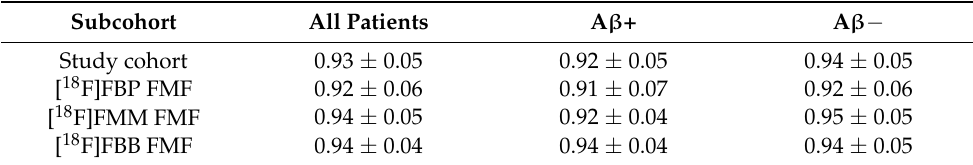
Figure 2. Intensity profiles and correlation charts with least squares line of the mean SUVRs of FMFs and [ 18 F]FDG PET. ( a , b ) Study cohort; ( c , d ) [ 18 F]FBP FMFs; ( e , f ) [ 18 F]FMM FMFs; and ( g , h ) [ 18 F]FBB FMFs. Brain regions are sorted as specified in Table S1 of the Supplementary Material (left hemisphere followed by right hemisphere). Table 3. Mean ± SD intrapatient correlation coefficients of FMFs and [ 18 F]FDG